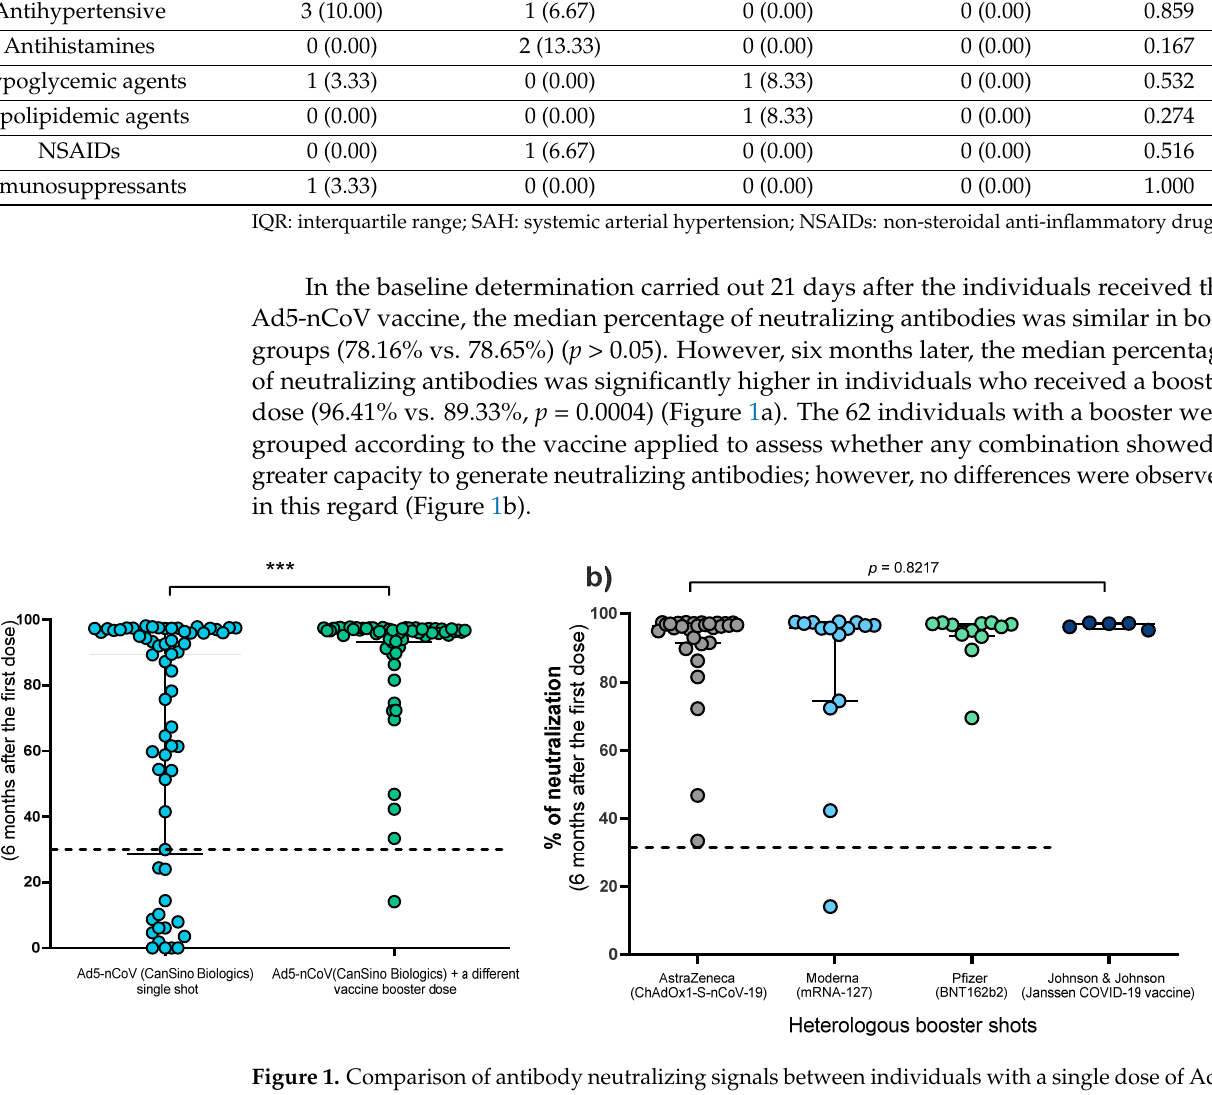
Figure 1. Comparison of antibody neutralizing signals between individuals with a single dose of Ad5- nCoV vaccine and individuals with a heterologous booster dose. ( a ) Individuals with a single dose of Ad5-nCoV vaccine vs. individuals with Ad5-nCoV dose and heterologous booster doses (AstraZeneca, Moderna, Pfizer, or Johnson & Johnson), differences were calculated by the Mann—Whitney’s U test. ( b ) Schemes of individuals with heterologous booster doses (Ad5-nCoV and AstraZeneca, Moderna, Pfizer, or Johnson & Johnson), differences were calculated by the Kruskal–Wallis test. The dotted line indicates the cut-off point for the neutralization test (>30%). ***, p < 0.0001. The neutralization percentage did not correlate with the time elapsed between the first vaccine and the booster (data not shown, r = − 0.06, p =